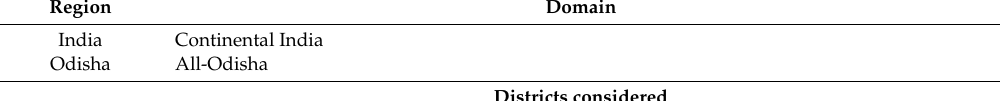
Table 1. Detailed coverage of the different regions of Odisha. Region